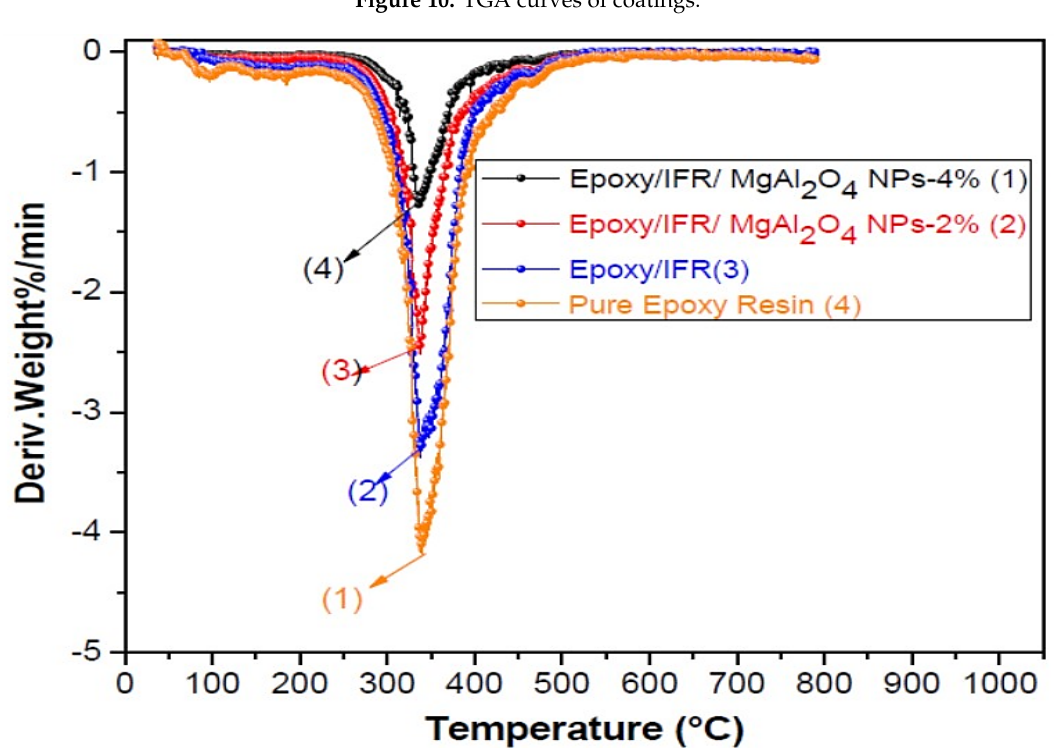
Figure 11. DTG curves of coatings.